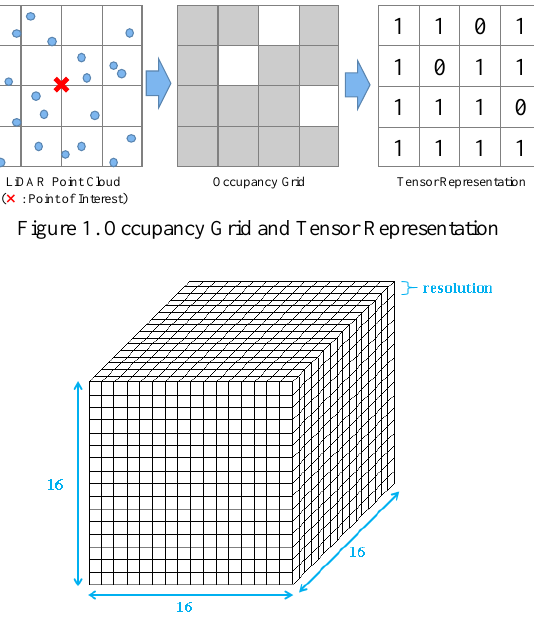
Figure 2. 16 x 16 x 16 voxels and resolution